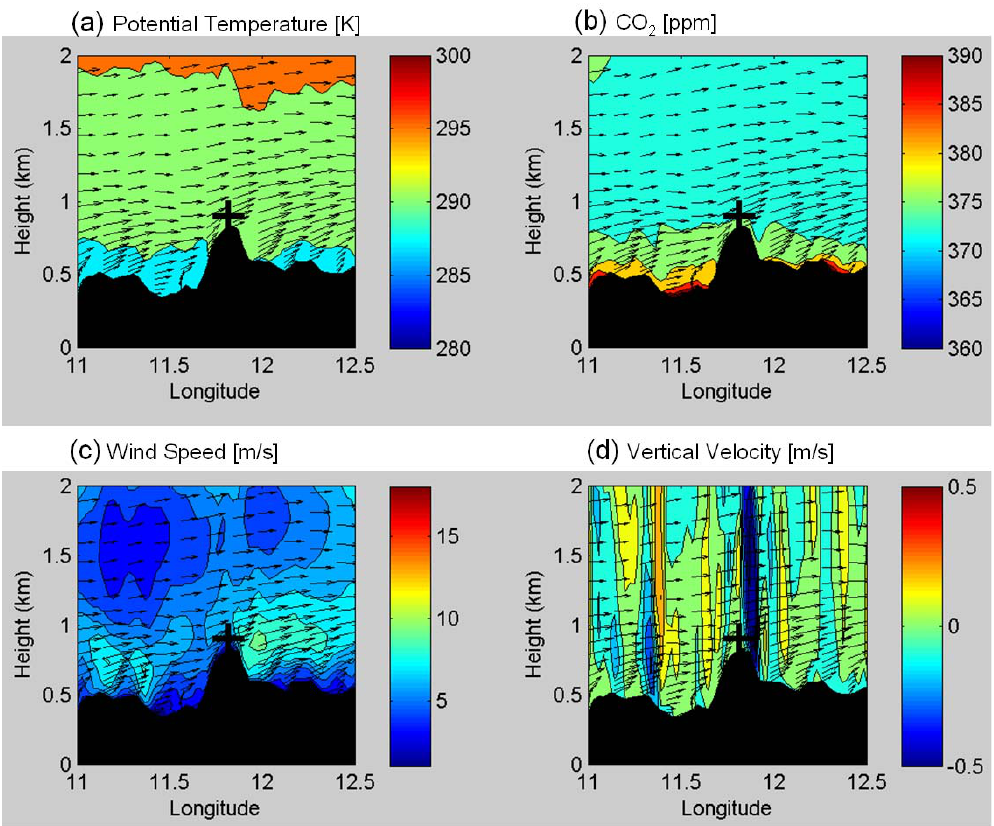
Fig. 10. Vertical cross section along OXK latitude (50 ◦ 01”N) on 27 August 2006 at 01:00UTC, showing WRF-VPRM simulated (a) Potential temperature in Kelvin (b) CO 2 concentration in ppm (c) Wind speed in ms − 1 and (d) Vertical velocity in ms − 1 . The overlaid arrows indicate prevailed wind direction at different altitudes; the symbol “+” indicates OXK location.